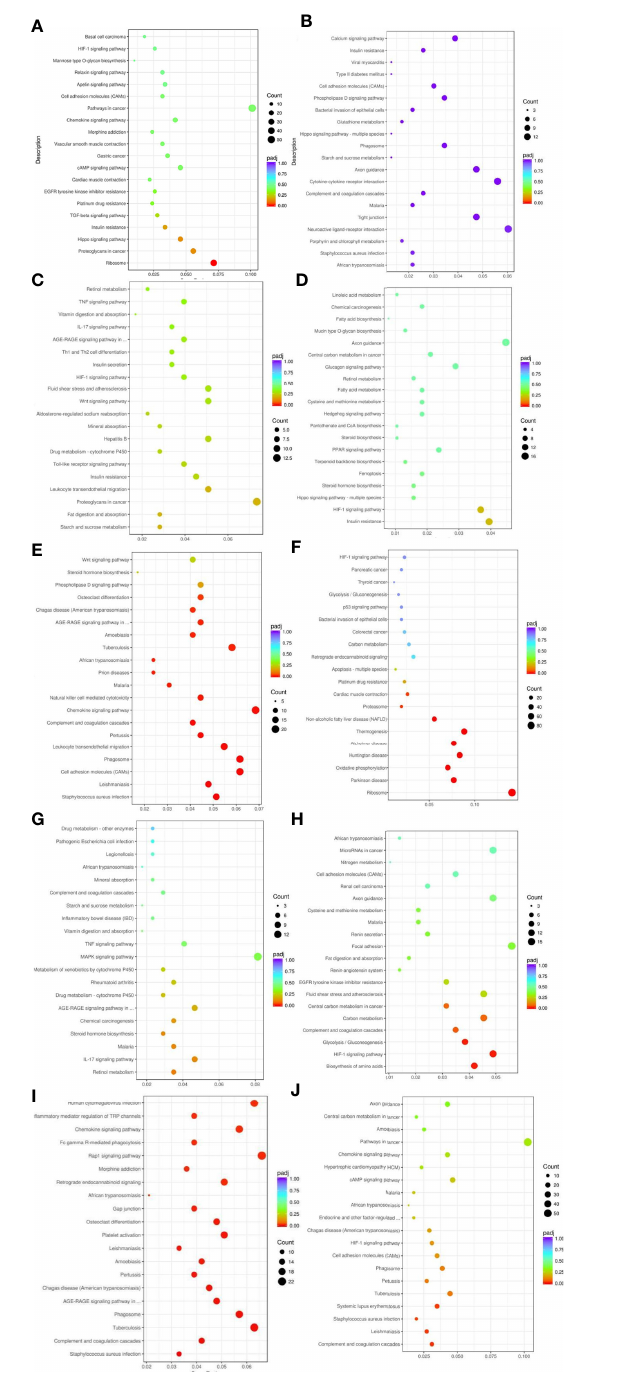
FIGURE 5 Results of KEGG pathway enrichment analysis of differentially expressed genes. From the KEGG enrichment results, the 20 most signi fi cant KEGG pathways were selected to plot scatter plots for display, and if there were less than 20, all pathways were plotted, as shown below. The horizontal coordinate of the graph is the ratio of the number of differential genes annotated to the total number of differential genes on the KEGG pathway, the vertical coordinate is the KEGG pathway, the size of the dot represents the number of genes annotated to the KEGG pathway, and the colour from red to purple represents the signi fi cance level of the enrichment. (A) Weight loss 1-5kg vs Control, (B) Weight loss 1-5kg vs Weight loss 0kg, (C) Weight loss 5-10kg vs Weight loss 1-5kg, (D) Weight loss 5-10kg vs Control, (E) Weight loss 5-10kg vs Weight loss 0kg, (F) Weight loss >10kg vs Weight loss 1-5kg, (G) Weight loss >10kg vs Weight loss 5-10kg, (H) Weight loss >10kg vs Control, (I) Weight loss >10kg vs Weight loss 0kg, (J) Weight loss 0kg vs